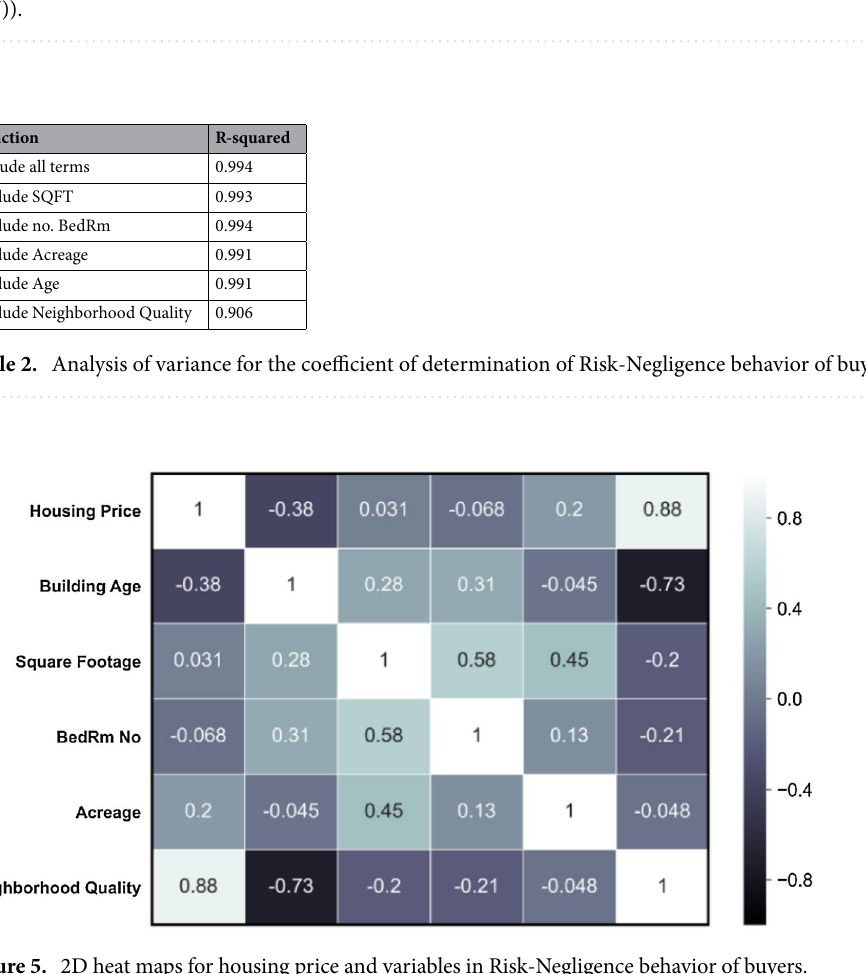
Table 1. Percentage of each behavior observed within floodplains (Risk-Negligence (RN) and Expected Utility (EU)).